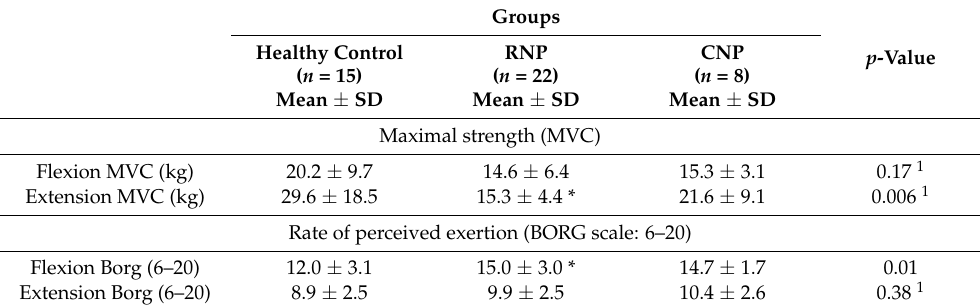
Table 5. Results of neck strength during the isometric contraction and perceived fatigue during submaximal contraction in